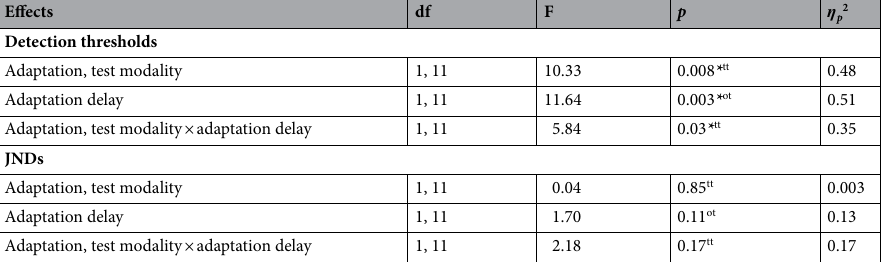
Table 5. Repeated-measures ANOVA results on detection thresholds and JNDs assessing transfer effects for adapt-A conditions. Bold asterisks indicate significant effects. ‘ ot ’ indicate one-tailed test values whereas ‘ tt ’ indicate two-tailed test values. df, degrees of freedom; F, F value, p , p value; ƞ p 2 partial eta-squared.